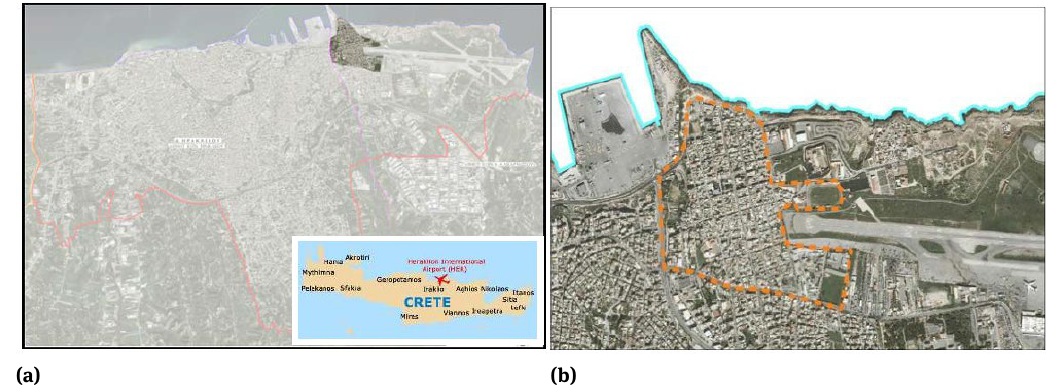
Fig. 1. Alikarnassos study area within Herakleion urban agglomeration and in a smaller scale on airport runway level.